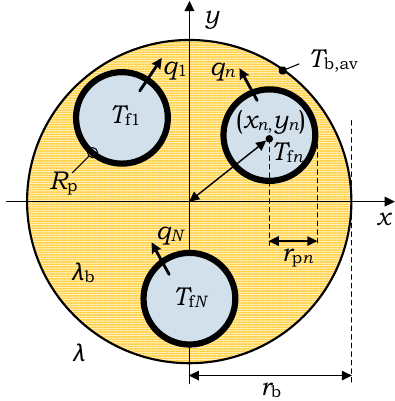
Figure 2. Steady-state heat conduction in a composite circular region with heat flows between N number of pipes and the adjacent ground region.